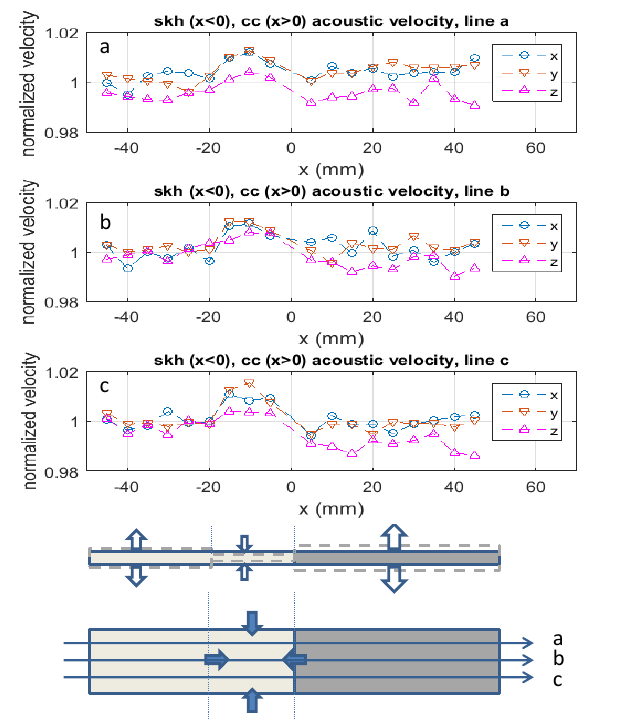
Figure 7. Relative acoustic velocity to nominal values for x , y and z direction (the top three rows). The bottom drawings illustrate compressive and tensile residual stresses qualitatively based on the relative acoustic velocity